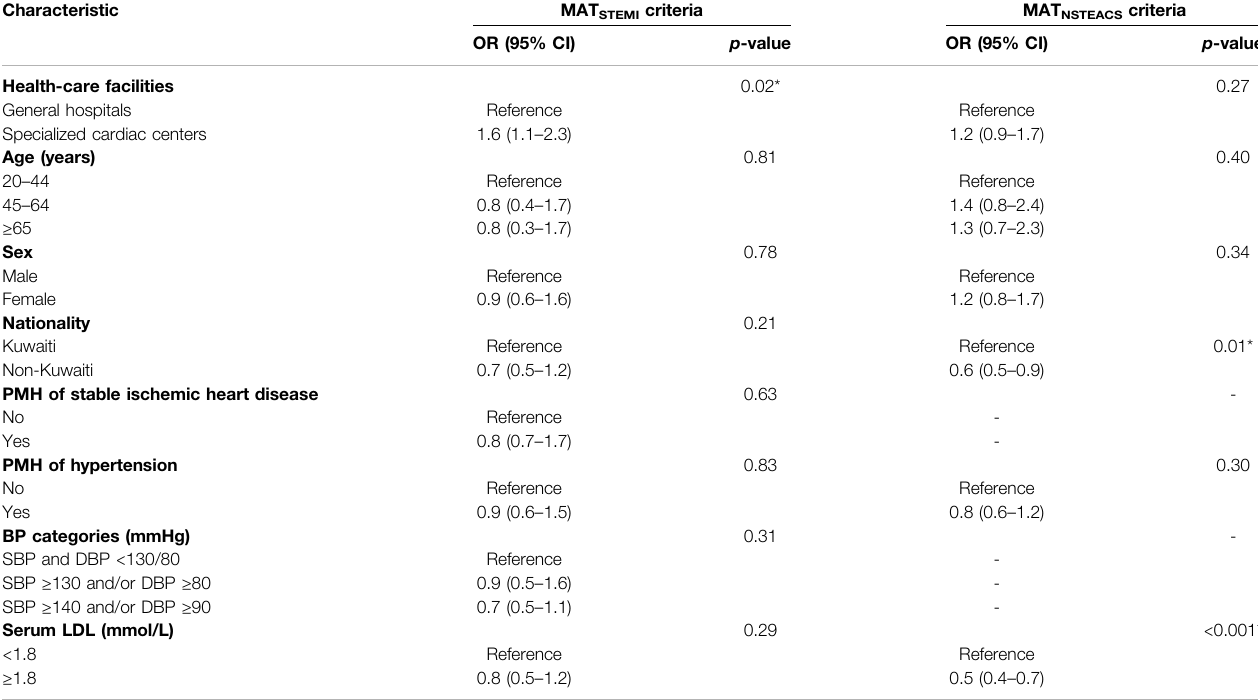
TABLE 5 | Association between the overall adherence to the MAT STEMI criteria and MAT NSTEACS criteria and patients ’ characteristics.